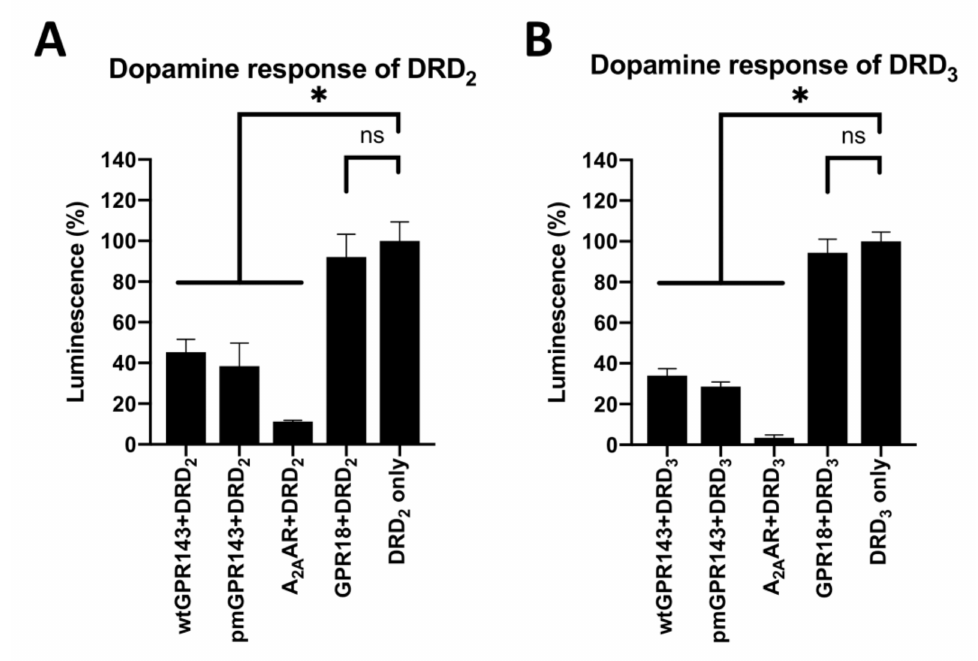
Figure 4. Dopamine response in CHO β -Arrestin cells expressing DRD 2 and DRD 3 co-transfected with a second GPCR. β -Arrestin assays were performed on dopamine treated CHO cells expressing DRD 2 ( A ) or DRD 3 ( B ), co-transfected with a second GPCR. The data were baseline corrected and correspond to 2–3 independent experiments performed in duplicates or triplicates. ( A ) Significant differences were observed between the DRD 2 alone and the other dimer pairs (vs. wtGPR143+DRD 2 p = 0.0113; vs. pmGPR143+DRD 2 p = 0.0052 and vs. A 2A AR+DRD 2 p = 0.0052), except for GPR18+DRD 2 where no significant difference was observed ( p = 0.8082). ( B ) Significant differ- ences were also observed between DRD 3 alone and the other dimer pairs (* = p < 0.0001 for all), except for GPR18+DRD 3 where no significant difference (ns = not significant) was observed ( p =